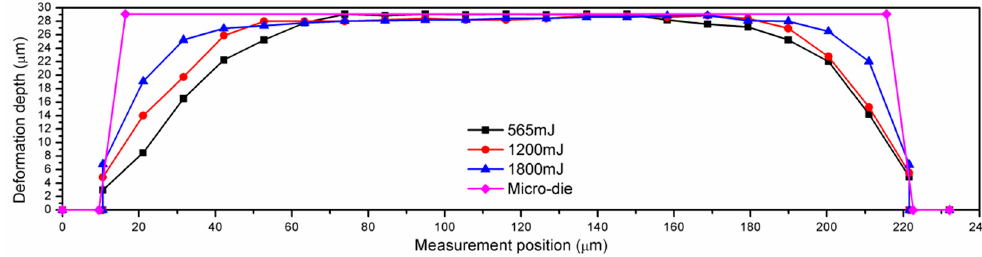
Figure 16. Sectional curves of the replicated features under different laser energy.